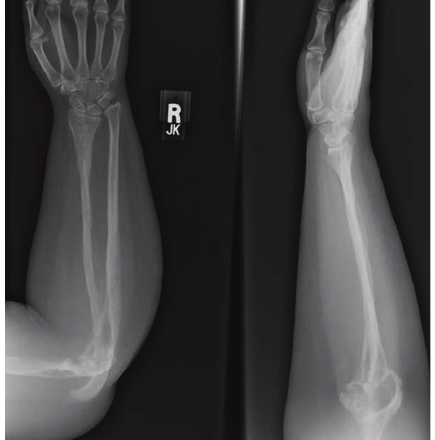
Figure 4: Anteroposterior and lateral plain radiographs of the forearm with multiple subcortical radiolucent foci of both the radius and ulna and subluxation of the distal radioulnar